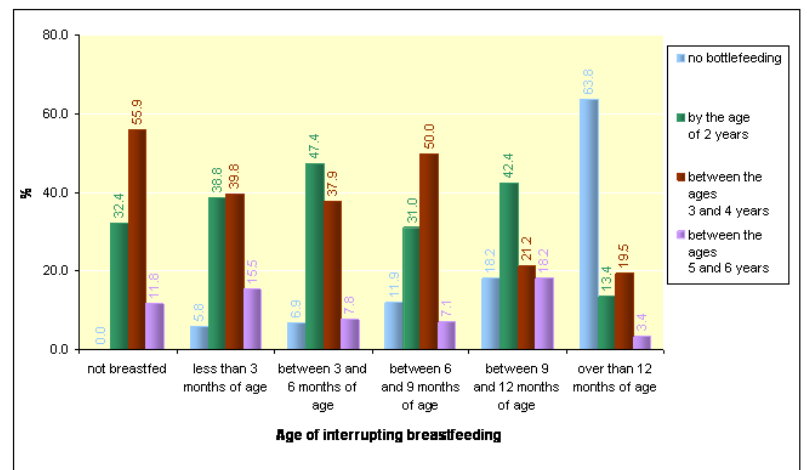
Fig.1. Distribution of the sample according to the bottle feeding duration in the breastfeeding